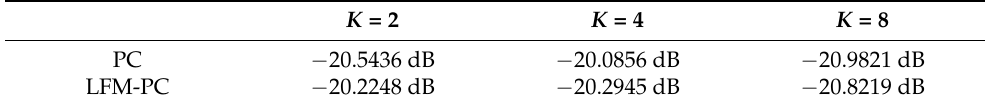
Table 4. AINSL before optimization.